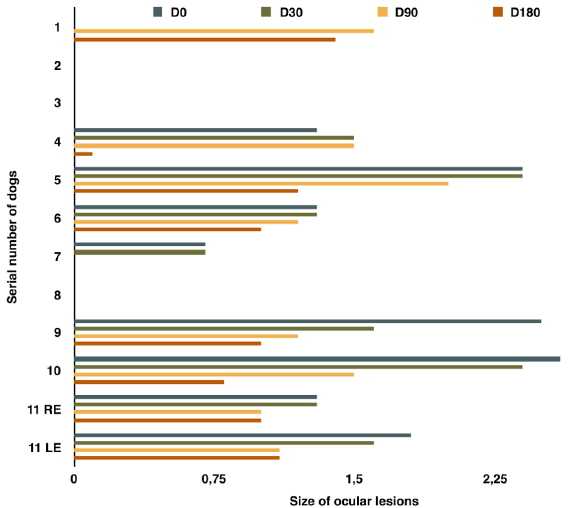
Fig 1. Size of ocular lesions in dogs enrolled in the efficacy study. Size of ocular lesions detected at the ultrasound imaging of eyes of dogs at 0 (D0), 30 (D30), 90 (D90) and 180 (D180) days post enrolment in animals in G1 (1–4), G2 (5–8) and G3 (8–11). RE = Right Eye; LE = Left Eye.